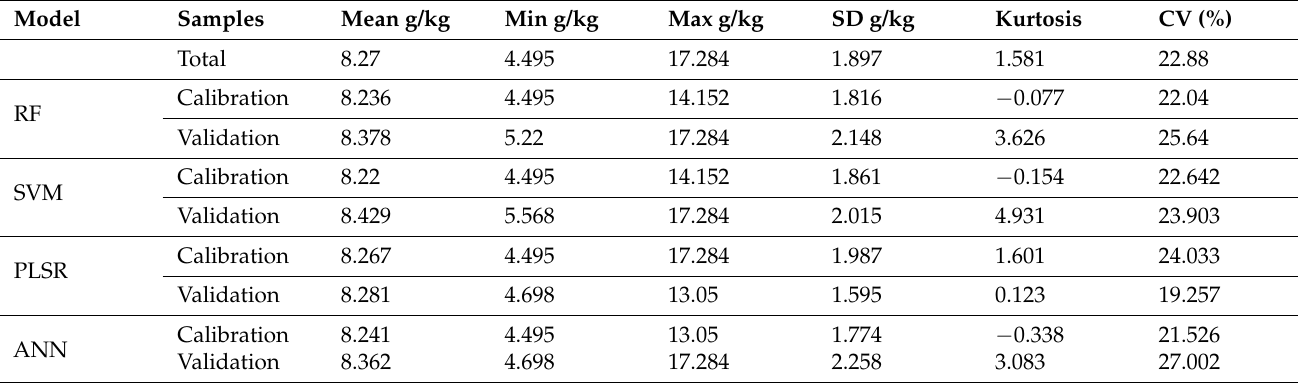
Table 4. General statistical description of soil organic carbon predictions from four models used in the western Guanzong Plain,